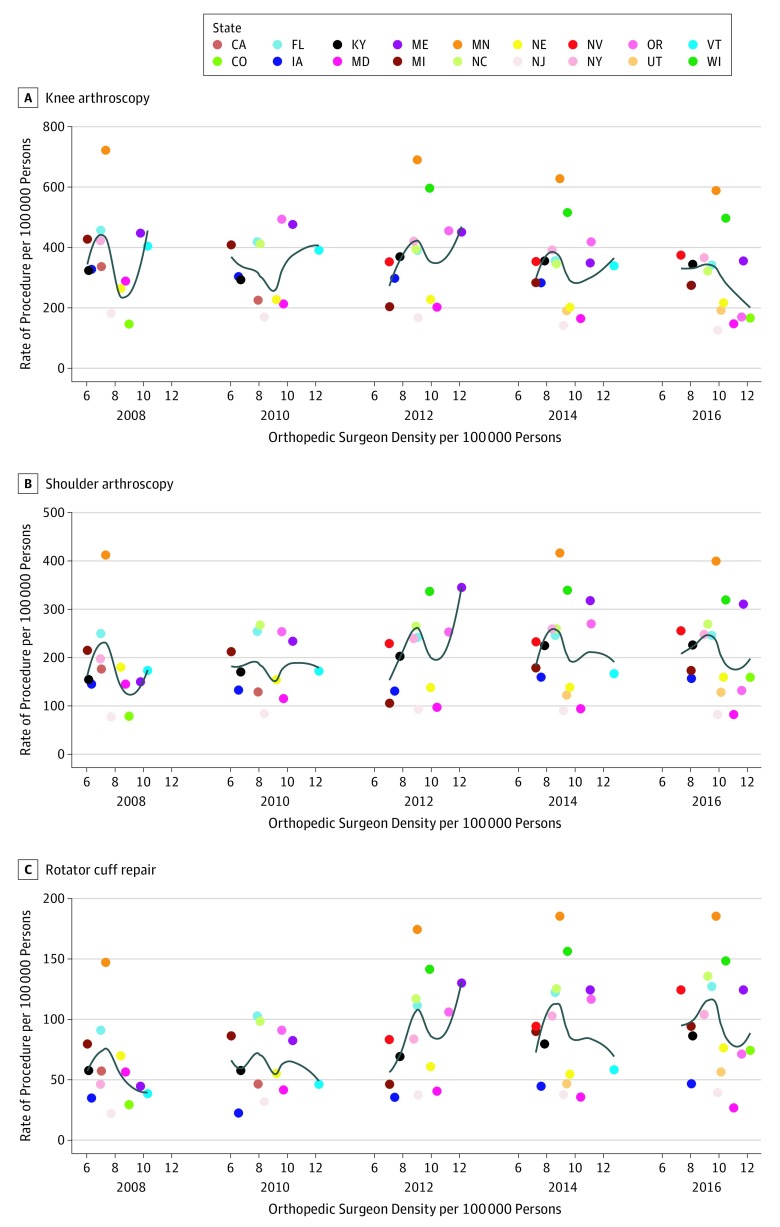
Rates of Knee Arthroscopy, Shoulder Arthroscopy, and Arthroscopic Rotator Cuff Repair in Select US States by Density of Orthopedic SurgeonsCA indicates California; CO, Colorado; FL, Florida; IA, Iowa; KY, Kentucky; MD, Maryland; ME, Maine; MI, Michigan; MN, Minnesota; NC, North Carolina; NE, Nebraska; NJ, New Jersey; NV, Nevada; NY, New York; OR, Oregon; UT, Utah; VT, Vermont; and WI, Wisconsin.